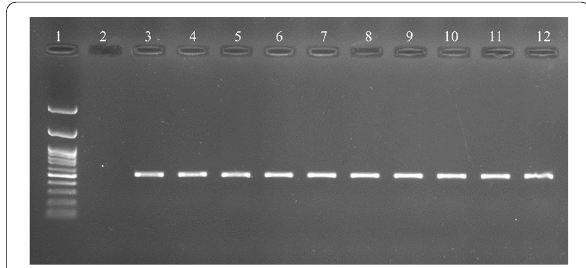
Fig. 1 Amplification of PCR products using specific primers of Inc-k14 on agarose gel 1%. Lines; 1: 100 bp DNA marker, 2: Negative control, 3–12: Collected samples of Meloidogyne (pure nematode population)